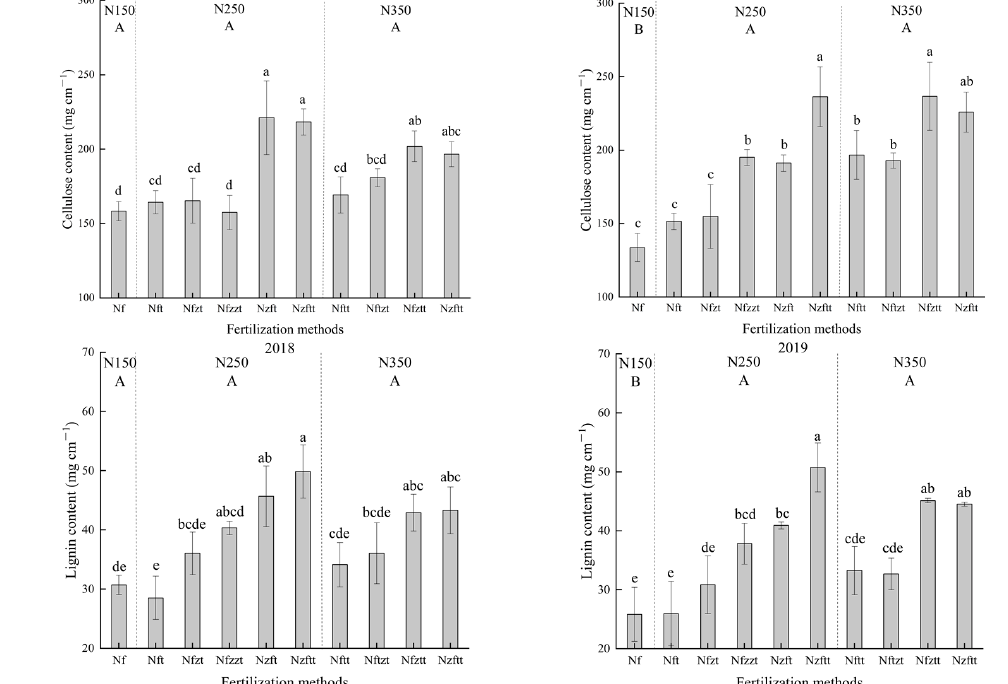
Figure 4. Effect of fertilization methods on cellulose and lignin contents of the third elongation internode at harvest stage under different nitrogen application rates. N150, N250, and N350 refer to the nitrogen application rate being 150, 250, and 350 kg ha − 1 , respectively. “z” refers to the nitrogen application rate being zero, “f” refers to the nitrogen application rate being 150 kg ha − 1 , “t” refers to the nitrogen application rate being 100 kg ha − 1 , e.g., Nf refers to nitrogen application rate being 150 kg ha − 1 at sowing stage; Nfzt refers to nitrogen application rate being 150, 0, and 100 kg ha − 1 at sowing, 6-leaf, and 12-leaf stages, respectively; Nzftt refers to the nitrogen application rate being 0, 150, 100, and 100 kg ha − 1 at sowing, 6-leaf, 12-leaf and silking stages, respectively. Capital letters indicate a significant difference at the p < 0.05 level under different nitrogen application rates. Lowercase letters indicate a significant difference at the p < 0.05 under all treatments.